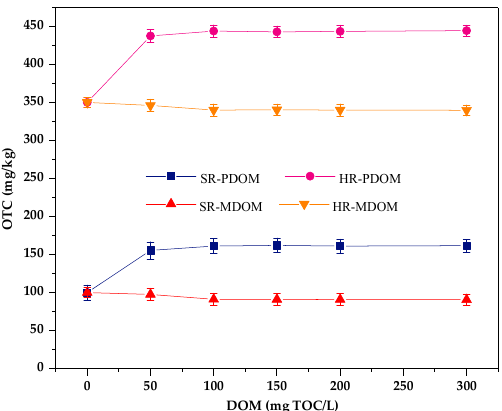
Figure 5. Effects of different DOM types on the adsorption of OTC in humus (HR) and sediment (SR) soil.